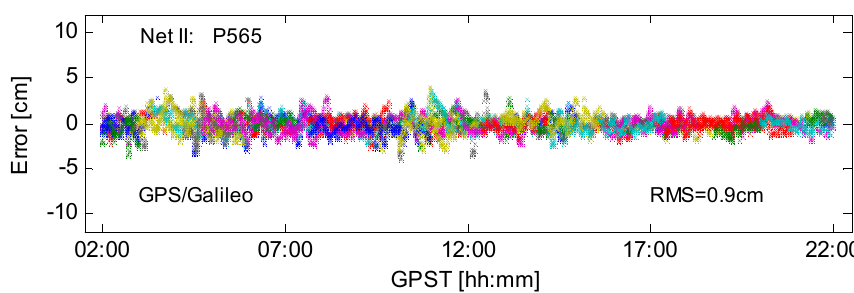
Figure 8. BSSD ionosphere interpolation errors of GPS/Galileo at station P565.